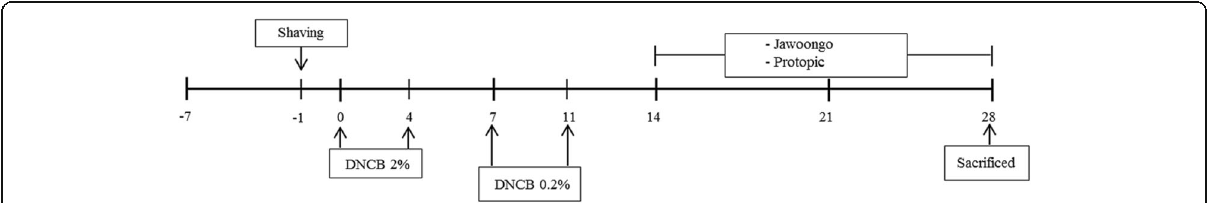
Fig. 1 General schematic diagram for the study